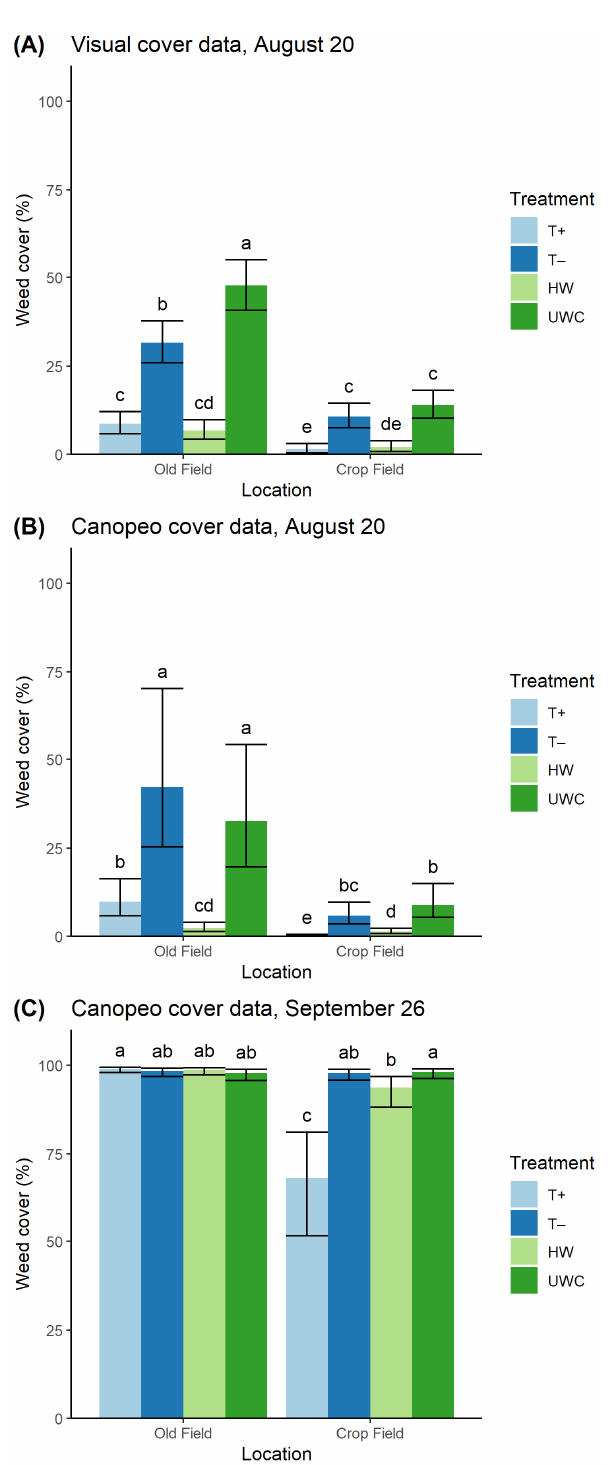
Figure 2. Effects of weeding treatment and location on weed cover. ( A , B ) Weed cover estimated visually or by Canopeo on 20 August 2019. ( C ) Weed cover estimated by Canopeo on 26 September 2019. Bars marked with the same letter are not significantly different according to a Tukey test ( α = 0.05); 95% confidence intervals are shown. Abbreviations: T+—Tertill with trimmer; T–—Tertill without trimmer; HW—hand weeding by stirrup hoe; UWC—unweeded control. On August 20, weed density was affected by weeding treatment for monocot, dicot, annual, and biennial/perennial groups ( p < 0.01; Figure 3). Monocot, annual, and bien- nial/perennial weed densities were affected by location ( p < 0.05). Annual weed density